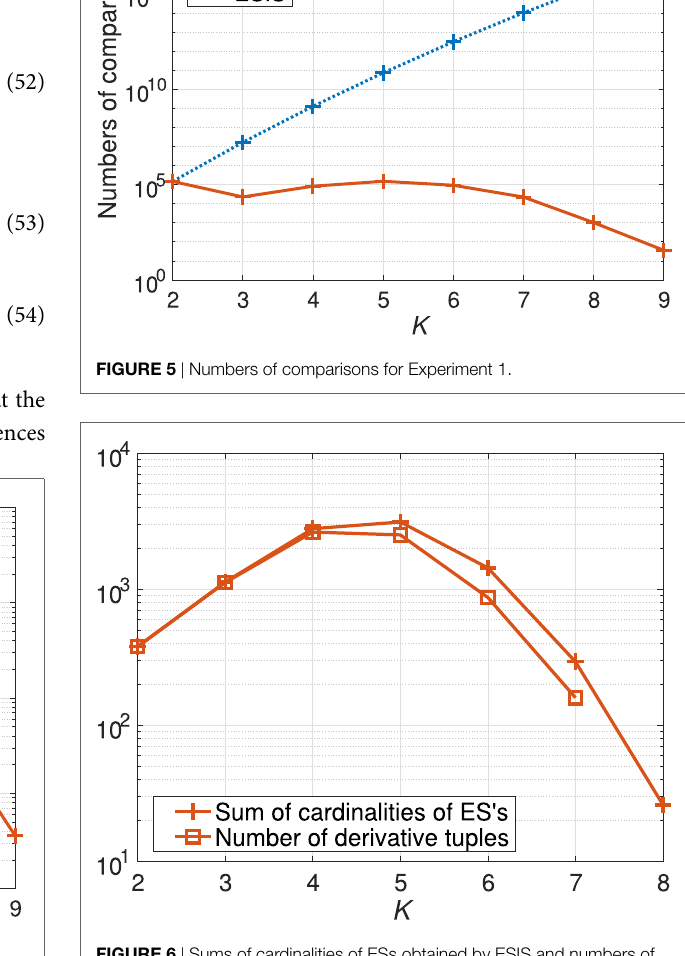
FIGURE 4 | Processing times for Experiment 1.